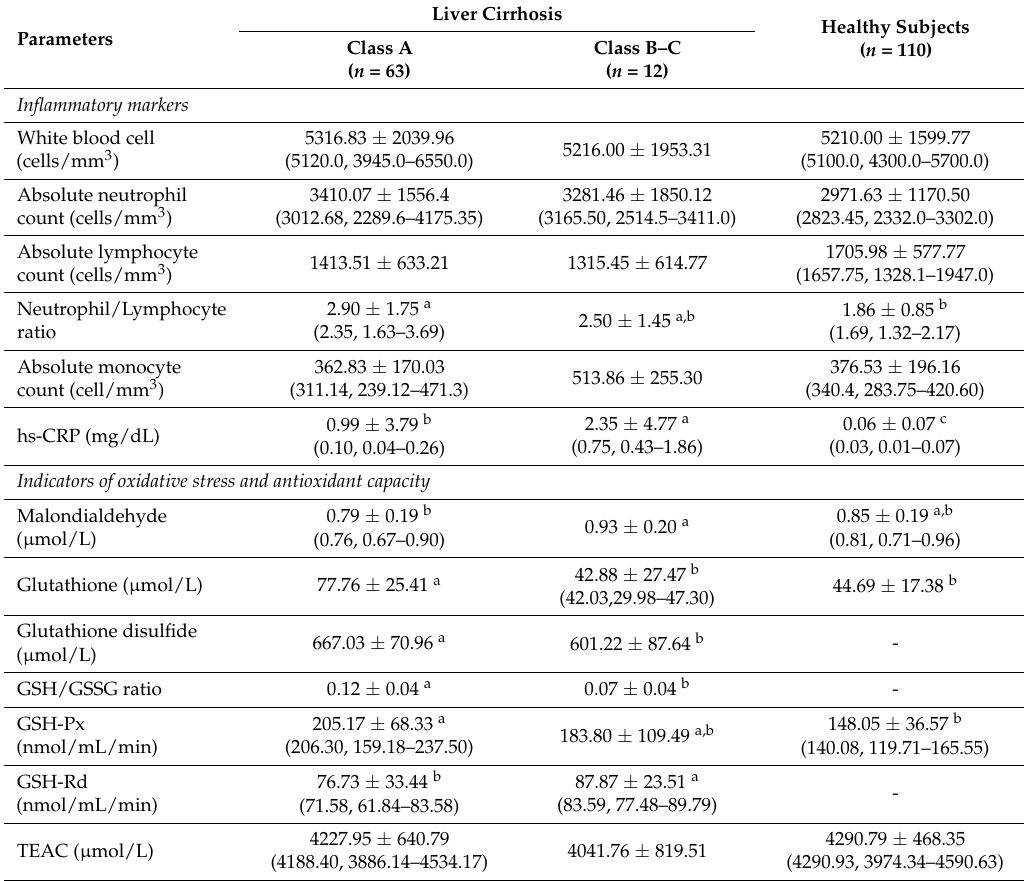
Table 2. Inflammatory markers and oxidative stress indicators in patients with liver cirrhosis and healthy subjects.